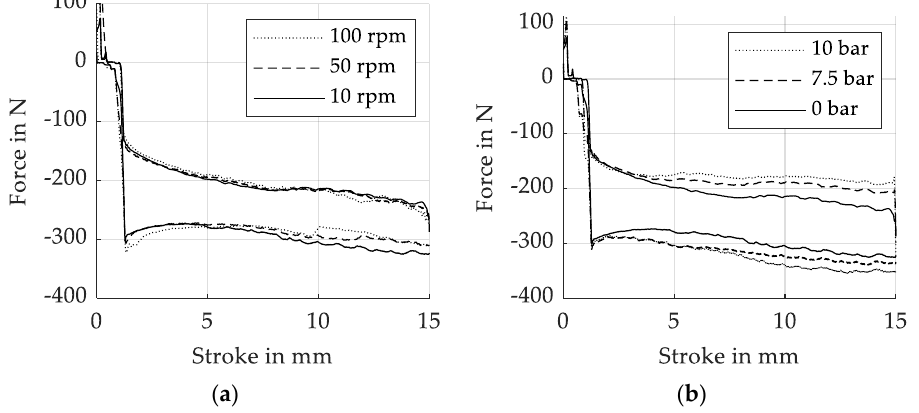
Figure 7. ( a ) The influence of actuator speed on necessary forces. ( b ) The relation between pressure level and friction forces.